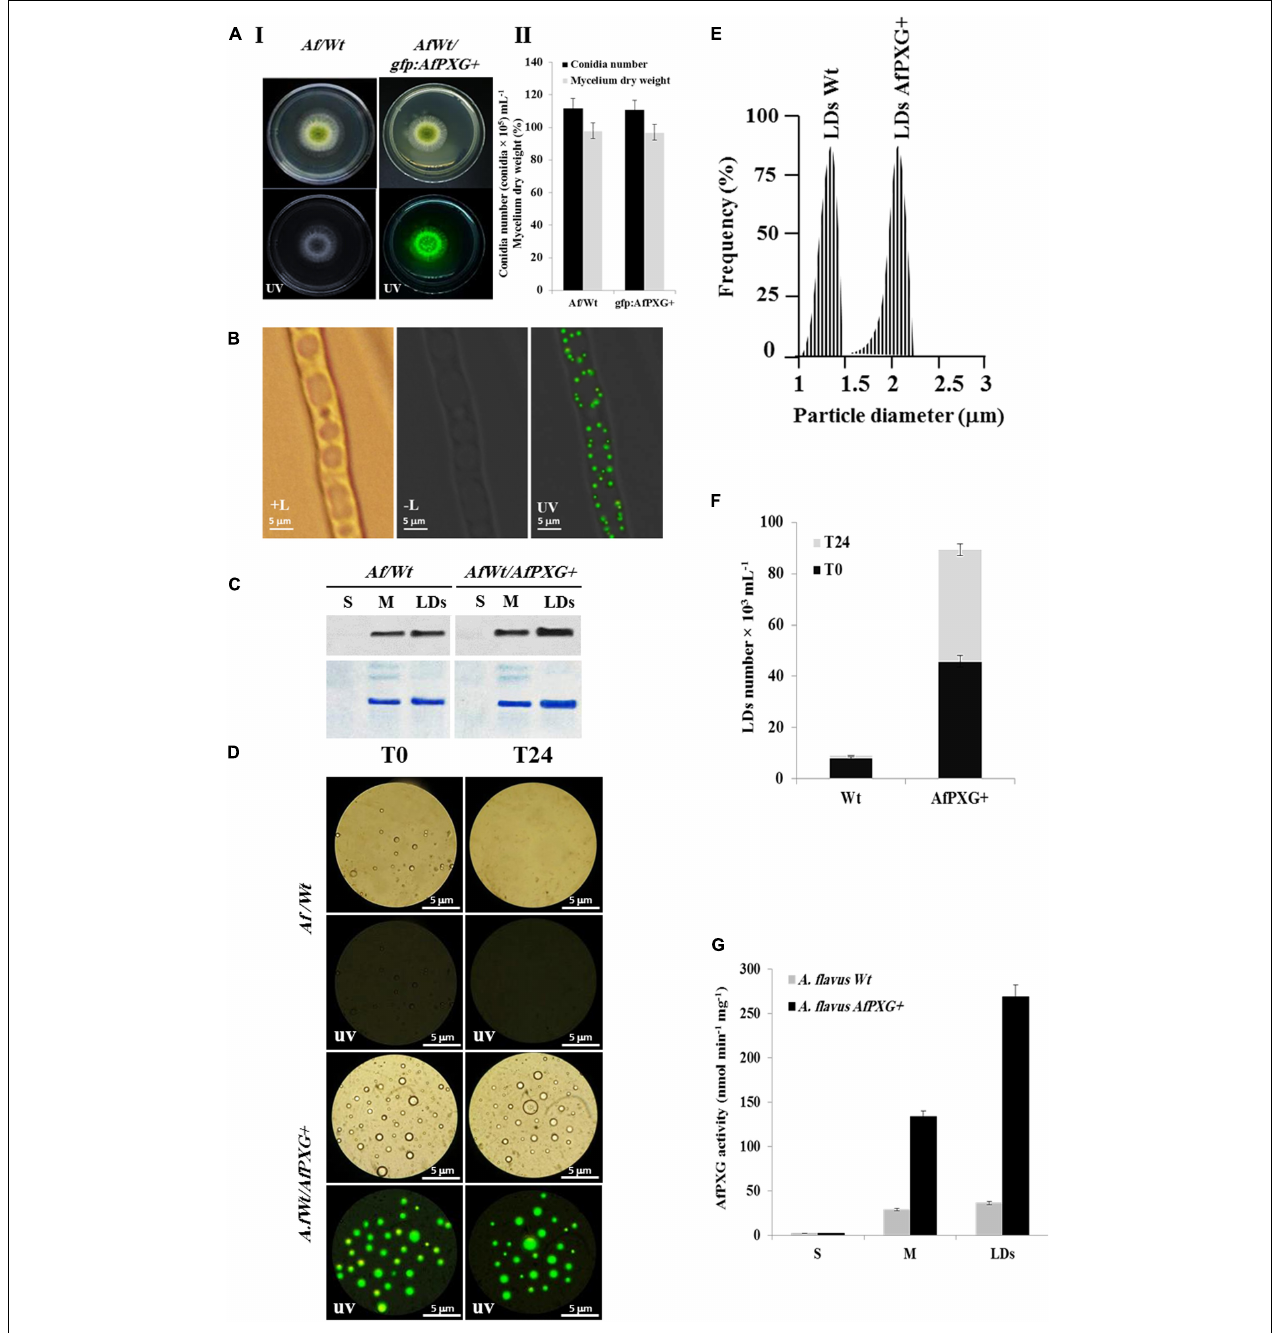
FIGURE 3 | Overexpression of AfPXG is associated with increased numbers of lipid droplets (LDs) in A. flavus . (A) Growth of AfPXG-overexpressing lines compared with WT. The AfPXG gene was overexpressed under the control of AdhI promoter as described in Section “Materials and Methods.” GFP was used as a reporter gene to evaluate the efficiency of target gene overexpression. The gfp:AfPXG+ line shows fluorescence under UV similar to the WT. (B) Light and fluorescent micrographs of isolated LDs from fungal tissue of A. flavus AfPXG+ line compared with WT. Purified LDs suspended in 100 mM potassium pyrophosphate at pH 7.4 were observed under a LEICA MPS60 microscope and images viewed at a magnification of 40 × immediately after preparation (T0) or 1 day later (T24). Bar represents 5 mm. (C) Immunodetection of overexpressed-AfPXG in different subcellular fractions, supernatant (S), microsomes (M), and LDs compared with their respective fractions isolated from the WT. An anti-PXG antibody was used at dilution of 1:500 in TBS buffer (pH 7.4). Horseradish peroxidase-conjugated anti-mouse IgG diluted 1:2000, served as the secondary antibody. The signal was detected in a Pharos FX molecular imager (Bio-Rad). Loading control are gels stained with Coomassie Brilliant Blue. (D–F) The purity, size, and number of LDs were evaluated by a Flow Cytometer at T0. (G) Evaluation of PXG activity (hydroxylation of aniline) in the supernatant (S), microsomes (M) and LDs from A. flavus AfPXG+ line compared with their respective fractions isolated from the WT. All measurements were done in triplicates. Results are means ± SD ( n =